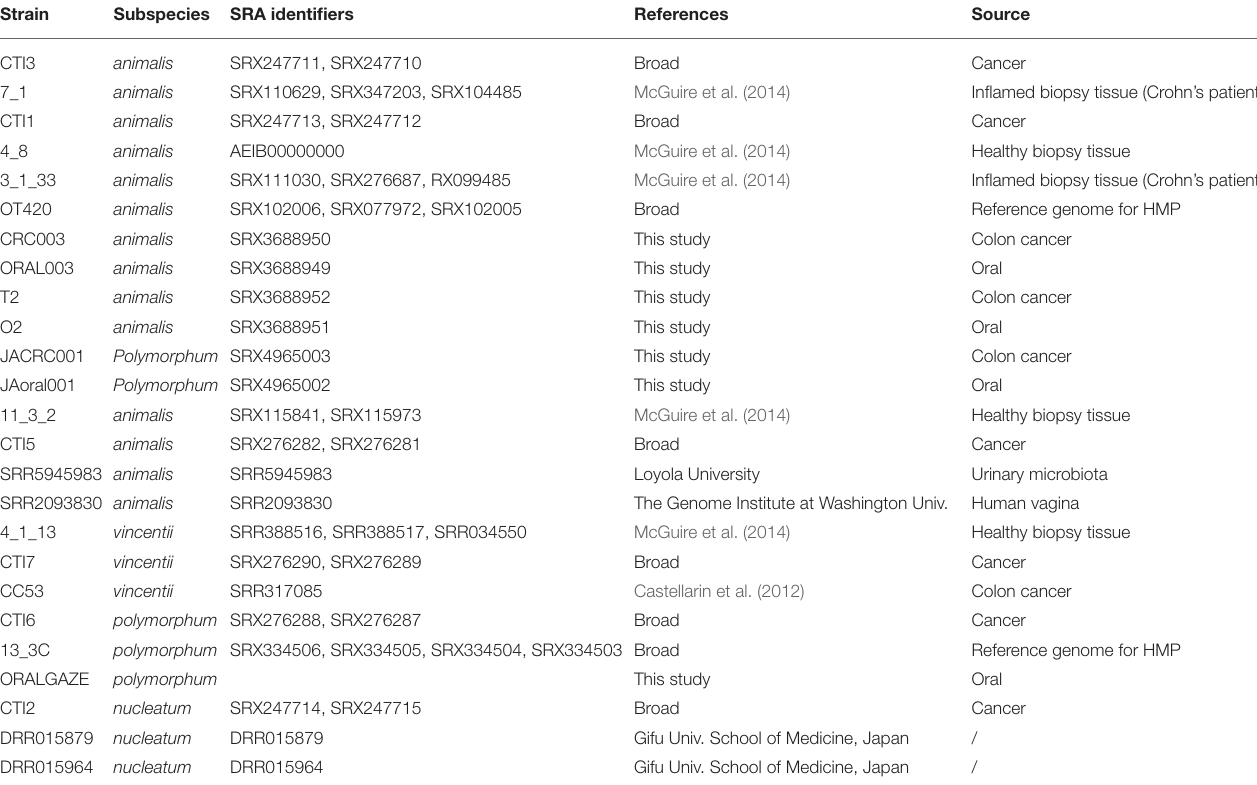
TABLE 1 | F. nucleatum strains used in this study.